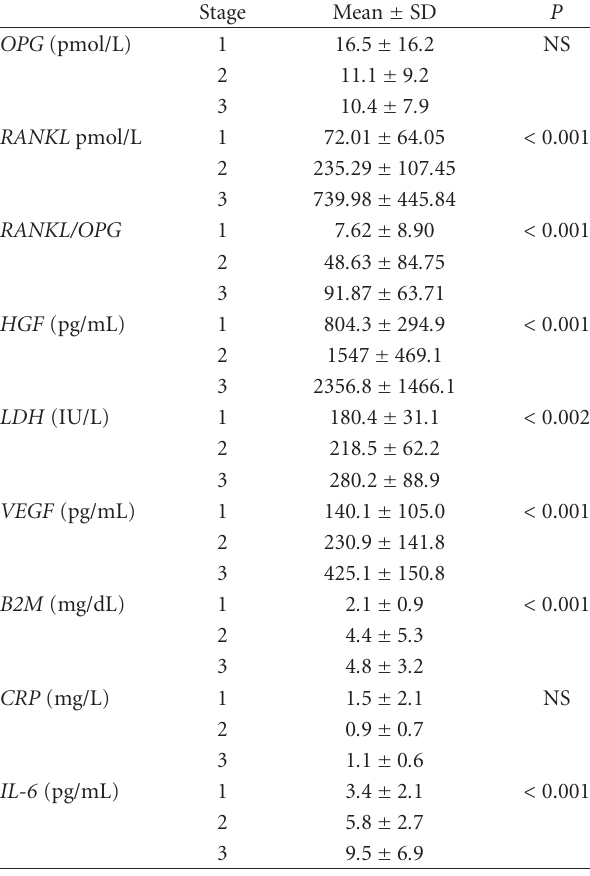
Table 2: Mean ± SD values of the measured parameters in the group of MM patients in di ff erent disease stages.